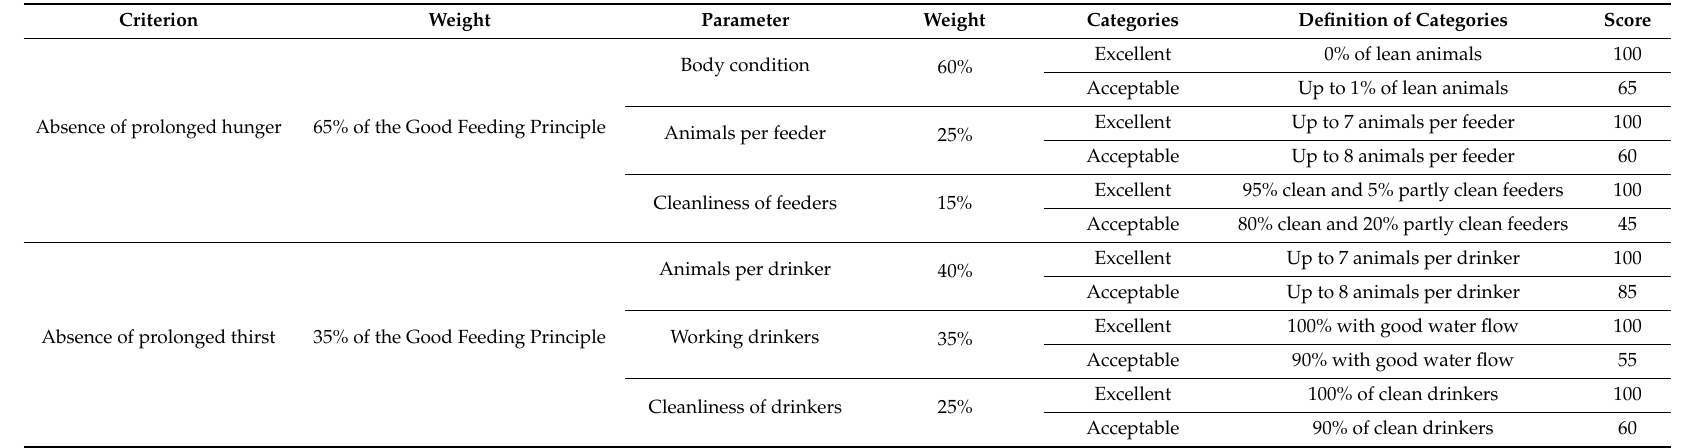
Table 2. Parameters used to assess the absence of prolonged hunger and the absence of prolonged thirst criteria within the Good Feeding Principle. The weight means which percentage of the score of the total criterion is represented by each parameter. Each parameter can be assessed according to two categories, excellent and acceptable, and are scored